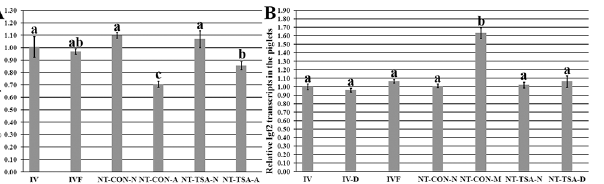
Fig 5. Relative Igf2 transcripts in fetuses and piglets. A, Igf2 transcripts in fetuses, and B, Igf2 expression levels in piglets. IV, the in vivo produced fetuses or piglets, IV-D, the in vivo produced dead piglets, IVF, the IVF fetuses or piglets, NT-CON-N, the normal cloned fetuses or piglets in the NT-CON group, NT-CON-A, the abnormal cloned fetuses in the NT-CON group, NT-CON-M, cloned piglets with macroglossia in the NT-CON group, NT-TSA-N, the normal cloned fetuses or piglets in the NT-TSA group, NT-TSA-A, the abnormal cloned fetuses in the NT-TSA group, and NT-TSA-D, the cloned dead piglets in the NT-TSA group. TSA improved the expression of Igf2 in cloned fetuses and piglets. The transcript abundance in the in vivo produced fetuses (A) or piglets (B) was considered to be the control. The data were expressed as mean ± SEM. a-c Values with different superscripts differ significantly (P <